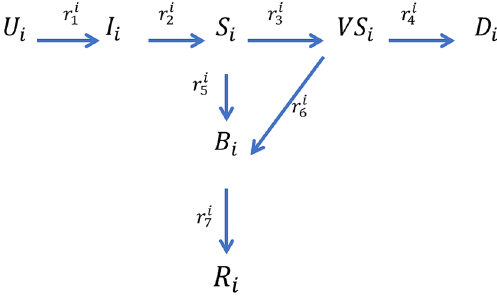
Figure 2. A schematic view of the extended SEIR EM, adapted from Ref. 4